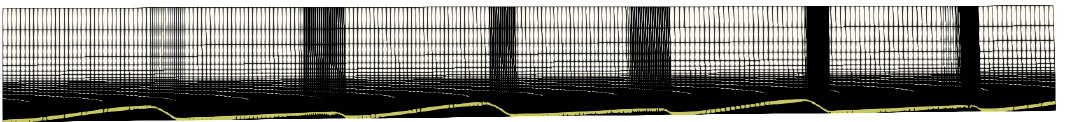
Figure 10. Simulation domain and bed boundary. ( a ) Sketch of the computational domain; ( b ) bed elevation of the 3D dunes in meters.